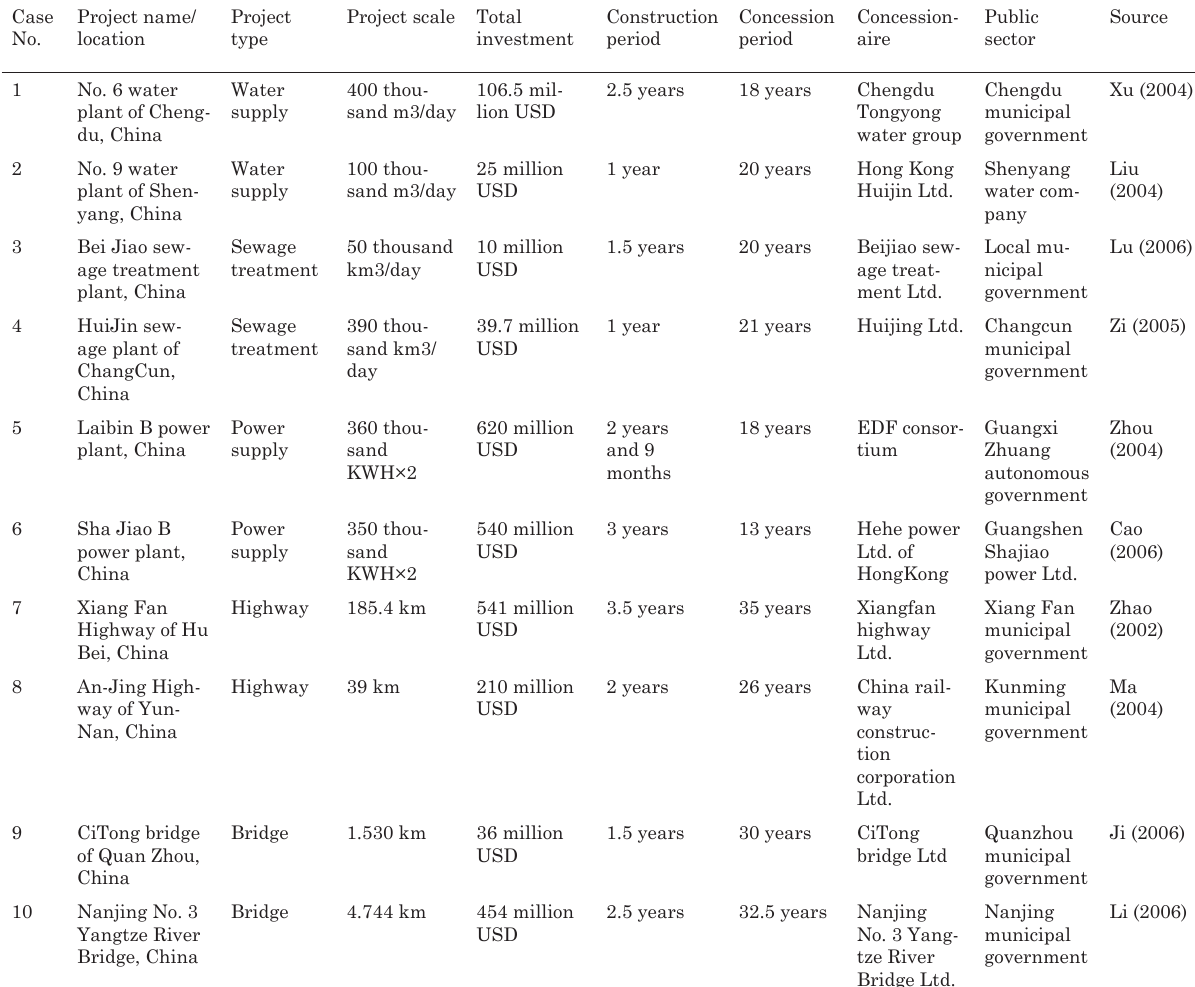
Table 2. Background information of PPP cases selected Case